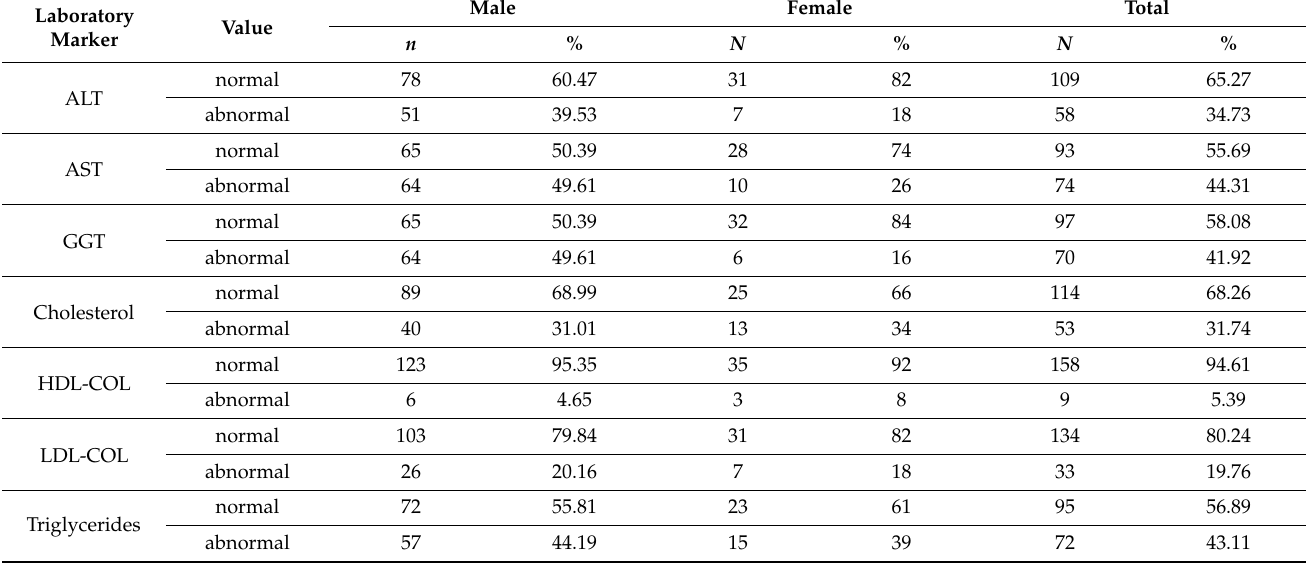
Table 6. Distribution of cases based on sex and metabolic syndrome and liver